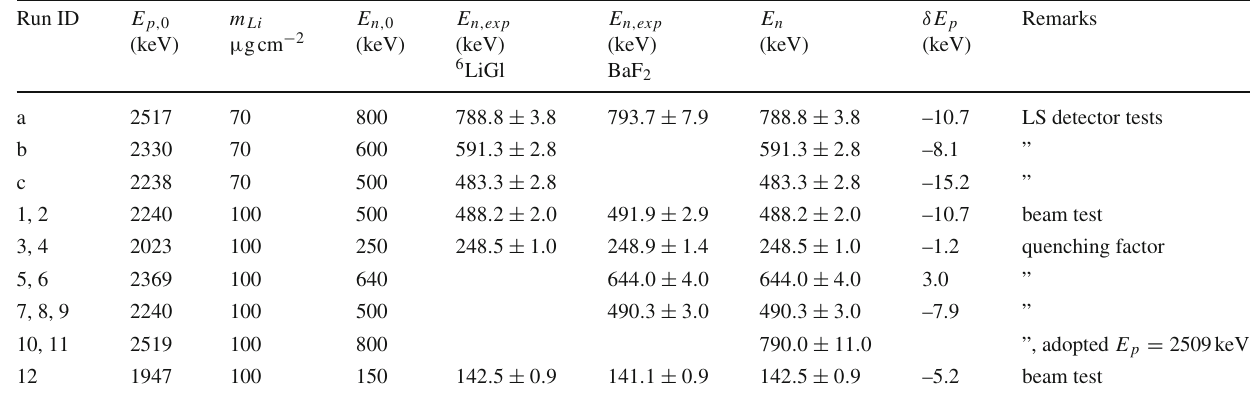
and the adopted value for the analysis in this article is named E n . The difference between the proton energy E p calculated from E n , exp and